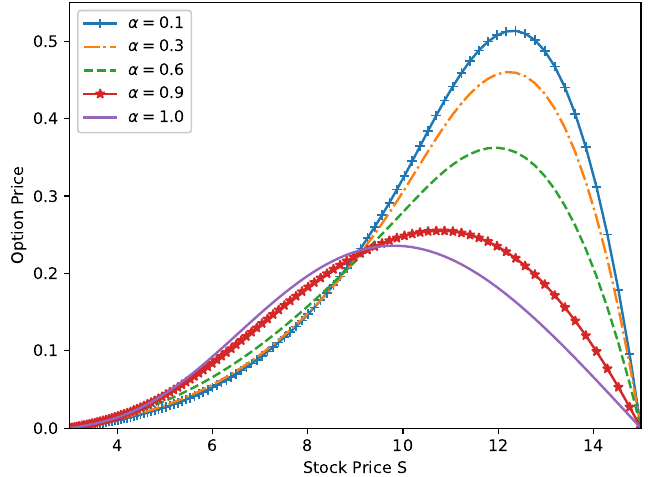
Figure 3. Numerical simulation of the double-barrier option prices with different α (Computed by the scheme (24) with N t = 100 and M x = 100 at α = 0.1,0.3,0.6,0.9, and